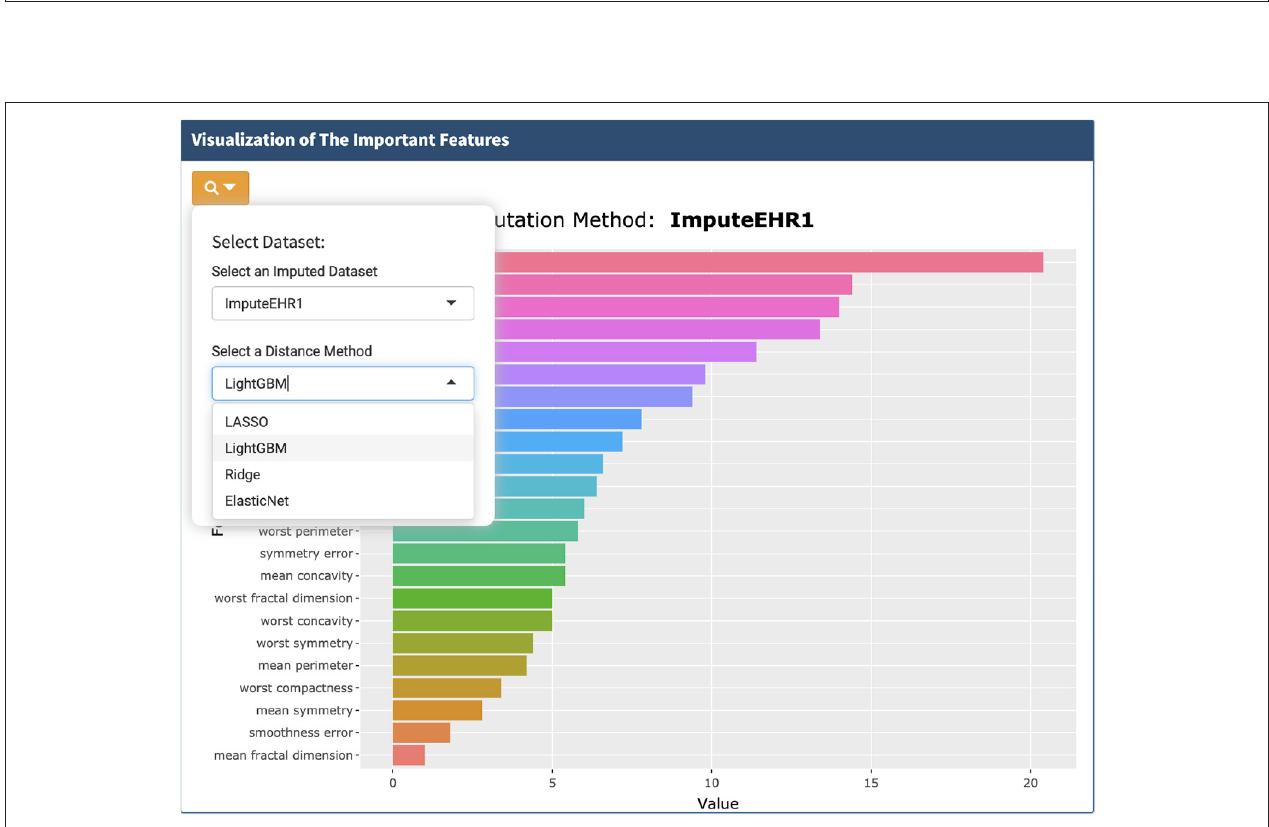
FIGURE 6 | Visualization of the important features selected by the four methods.